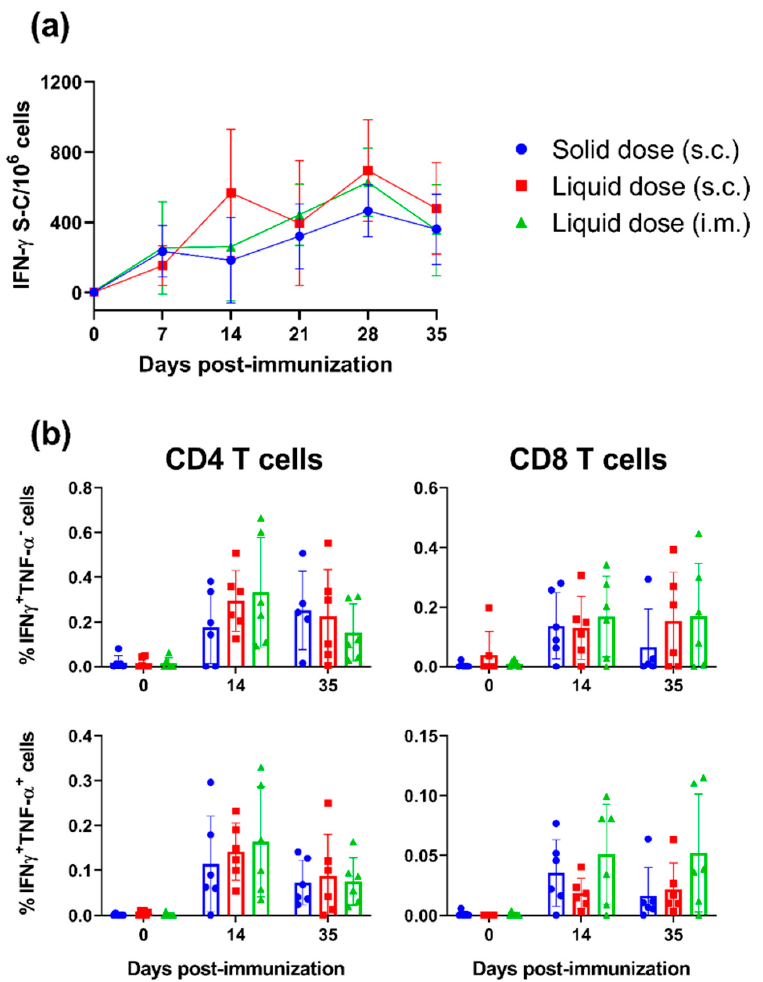
Figure 3. Assessment of T cell responses following immunisation of pigs with a unit solid dose injectable formulation of live attenuated PRRSV-1. Three groups of pigs (n = 6) were immunised by s.c. inoculation of a USDI formulation of 10 5 TCID 50 of PRRSV-1 Olot/91, or by s.c. or i.m. inoculation of a comparable dose of PRRSV-1 Olot/91 (s.c. liquid dose and i.m. liquid dose, respectively). Responses of PBMC to stimulation with PRRSV-1 Olot/91 were monitored weekly by ( a ) IFN- γ ELISpot and ( b ) responding cells phenotyped by intracellular cytokine staining (ICS) assays. ELISpot data are presented as the mock-corrected number of IFN- γ spot forming cells (S-C) per million PBMCs, and